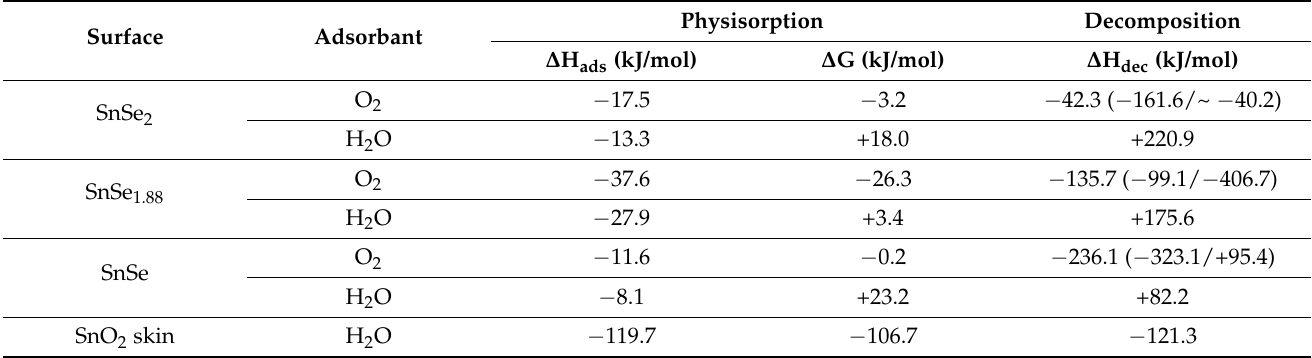
Table 1. Differential enthalpy ∆ Hads and differential Gibbs free energy ∆ G for physisorption at room temperature and differential enthalpy of decomposition ∆ H dec for molecular oxygen and water on the surface of bulk samples of SnSe 2 , SnSe 1.88 , and SnSe. For the decomposition of oxygen, we also report, in parenthesis, the differential enthalpy for the formation of an oxygenated surface and a SnO 2 -like layer.